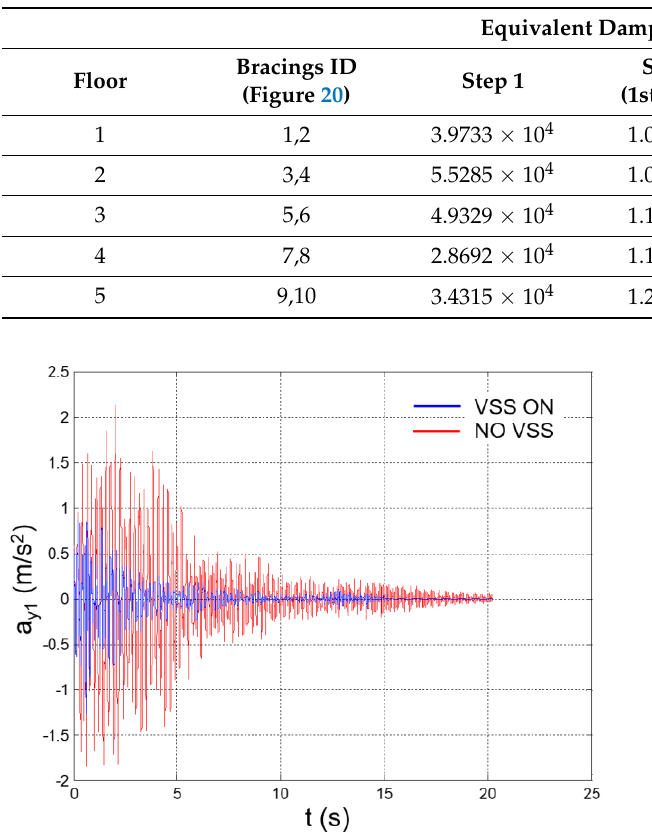
Figure 26. Seismic response, 1st-floor acceleration (Node 45) with respect to the ground.